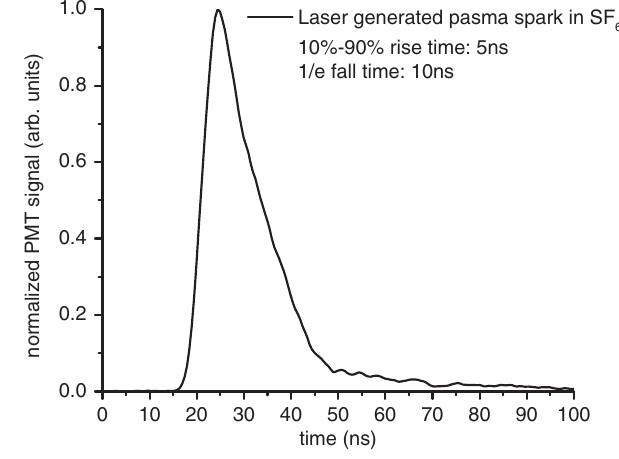
FIG. 5. Normalized LSD signal of the UV laser generated plasma spark in SF 6 . The 266 nm, 3 ns FWHM laser pulse had an energy of about 25 mJ. The pulse rise time is slightly longer than the expected 1.5 ns which is due to the response time limitation of the PMT and the digitizer. Likewise, the fluores- cence lifetime of 10 ns is also slightly prolonged by the same limitations.